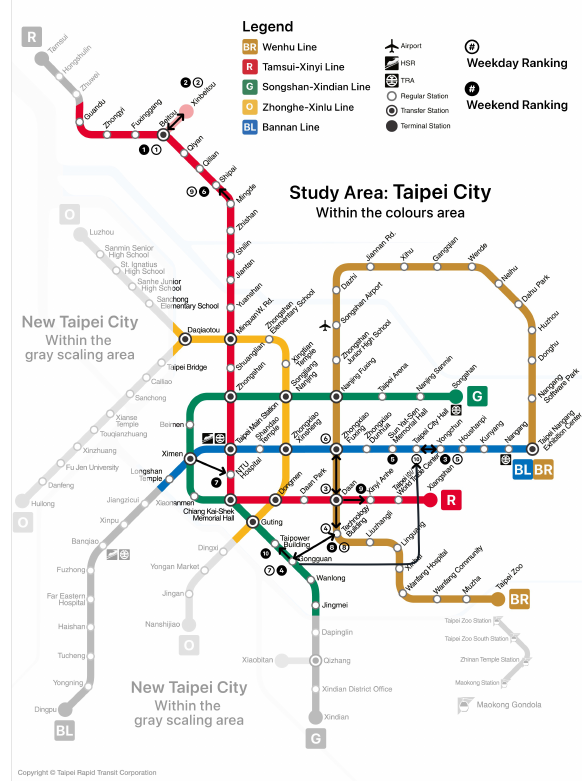
Fig. 4. Top 10 type C YouBike trips competing against